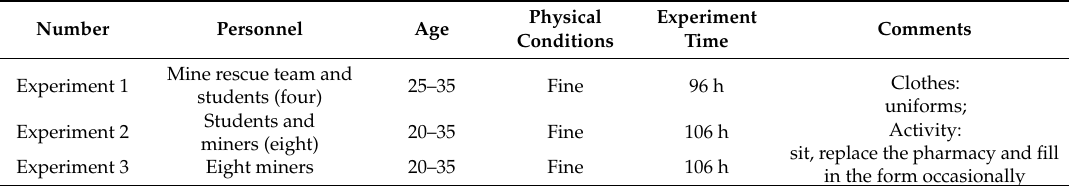
Table 1. Datasheet for Field Experiments.